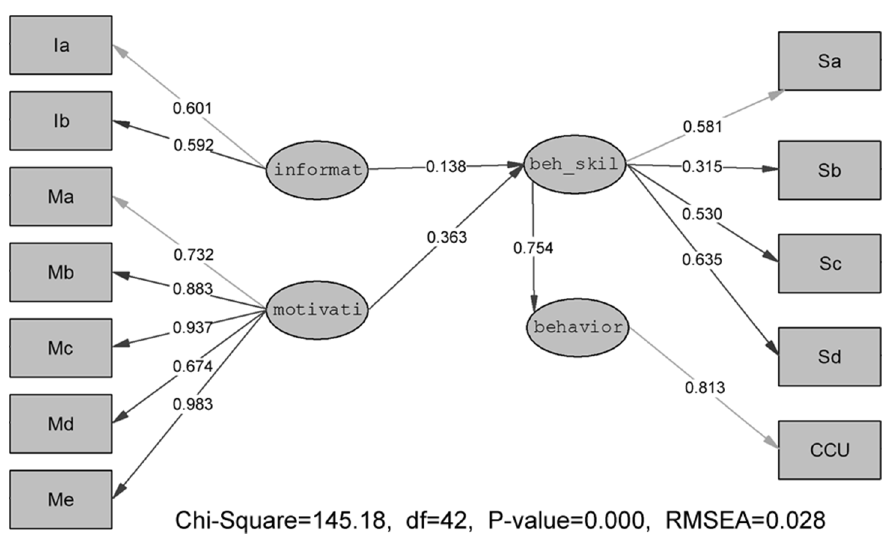
Figure 2. The final predictive IMB model. Structural equation model depicts regression paths in the IMB model (N=3183). Large circles represent latent variables; rectangles represent single-item indicators; single-headed arrows represent regression coefficients. Regression coefficients are standardized.